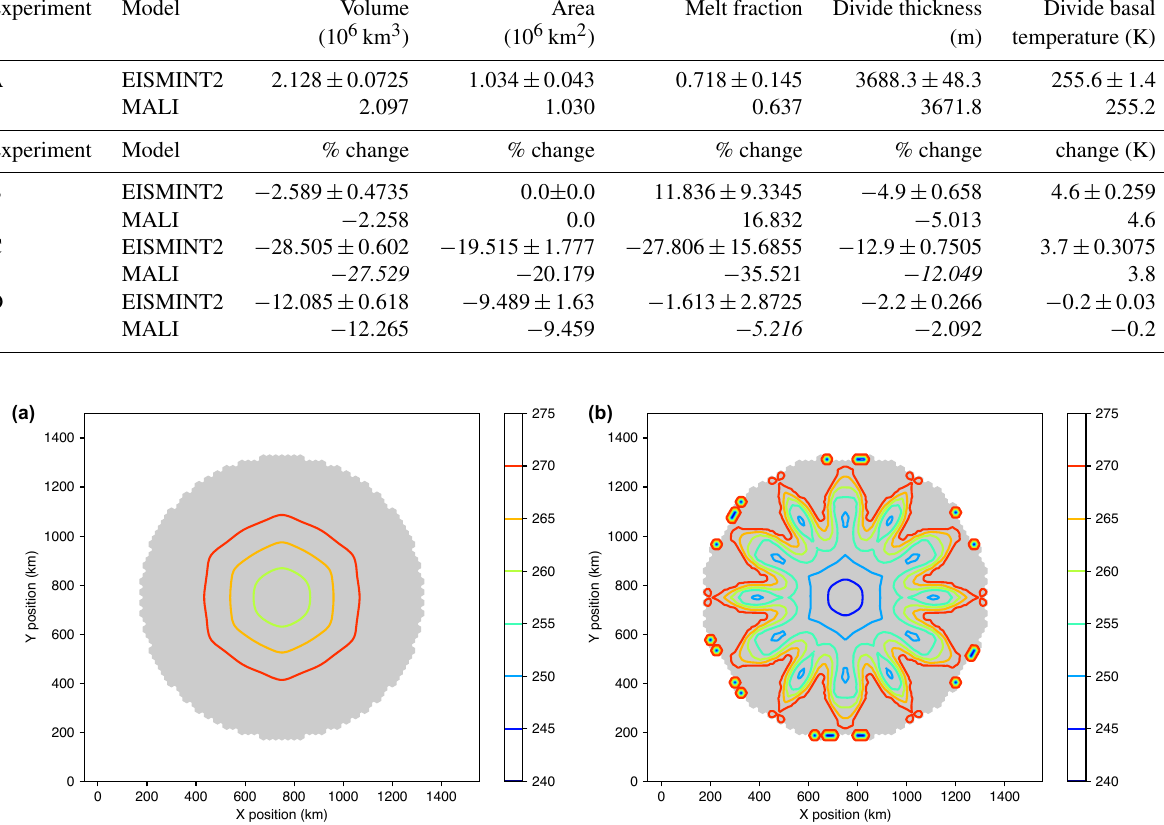
Figure 7. (a) Basal homologous temperature (K) for EISMINT2 experiment A. (b) Same for experiment F. Figures are plotted following Payne et al.